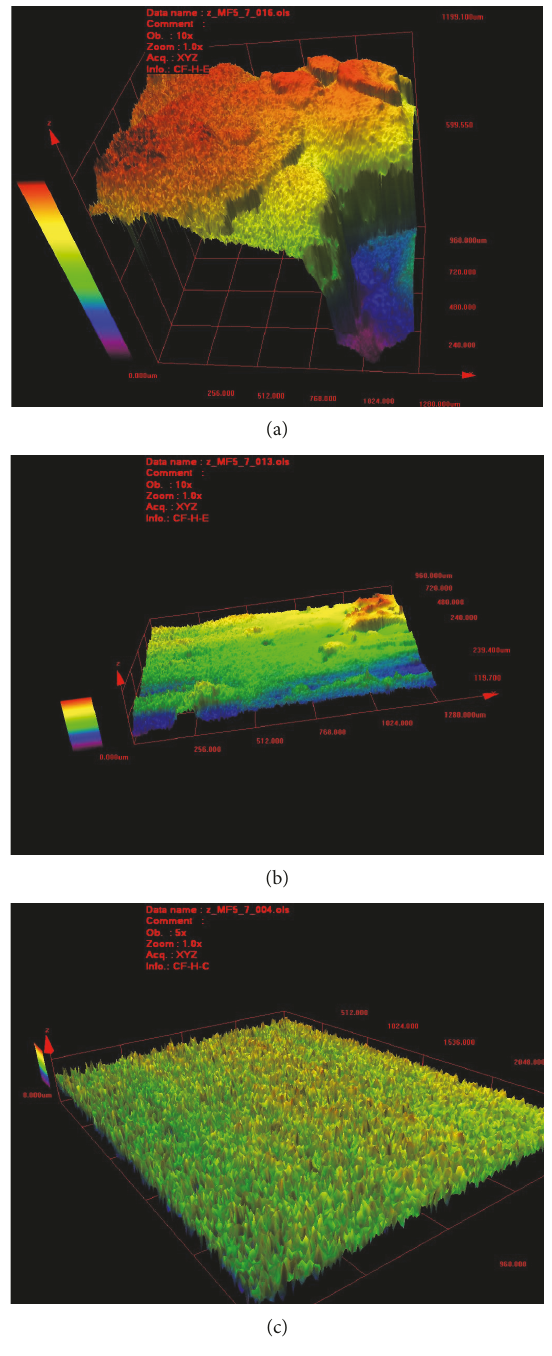
Figure 11: 3D images (0 < x < 1280 μ m; 0 < y < 960 μ m; z variable) obtained from surface samples analyzed with confocal laser scanning microscope: (a) mortar W/C =0.4, 600 steps of 2 μ m with an optical zoom x10, (b) mortar W/C =0.5, 250 steps of 1 μ m with an optical zoom x10, and (c) wood, 200 steps of 1 μ m with an optical zoom